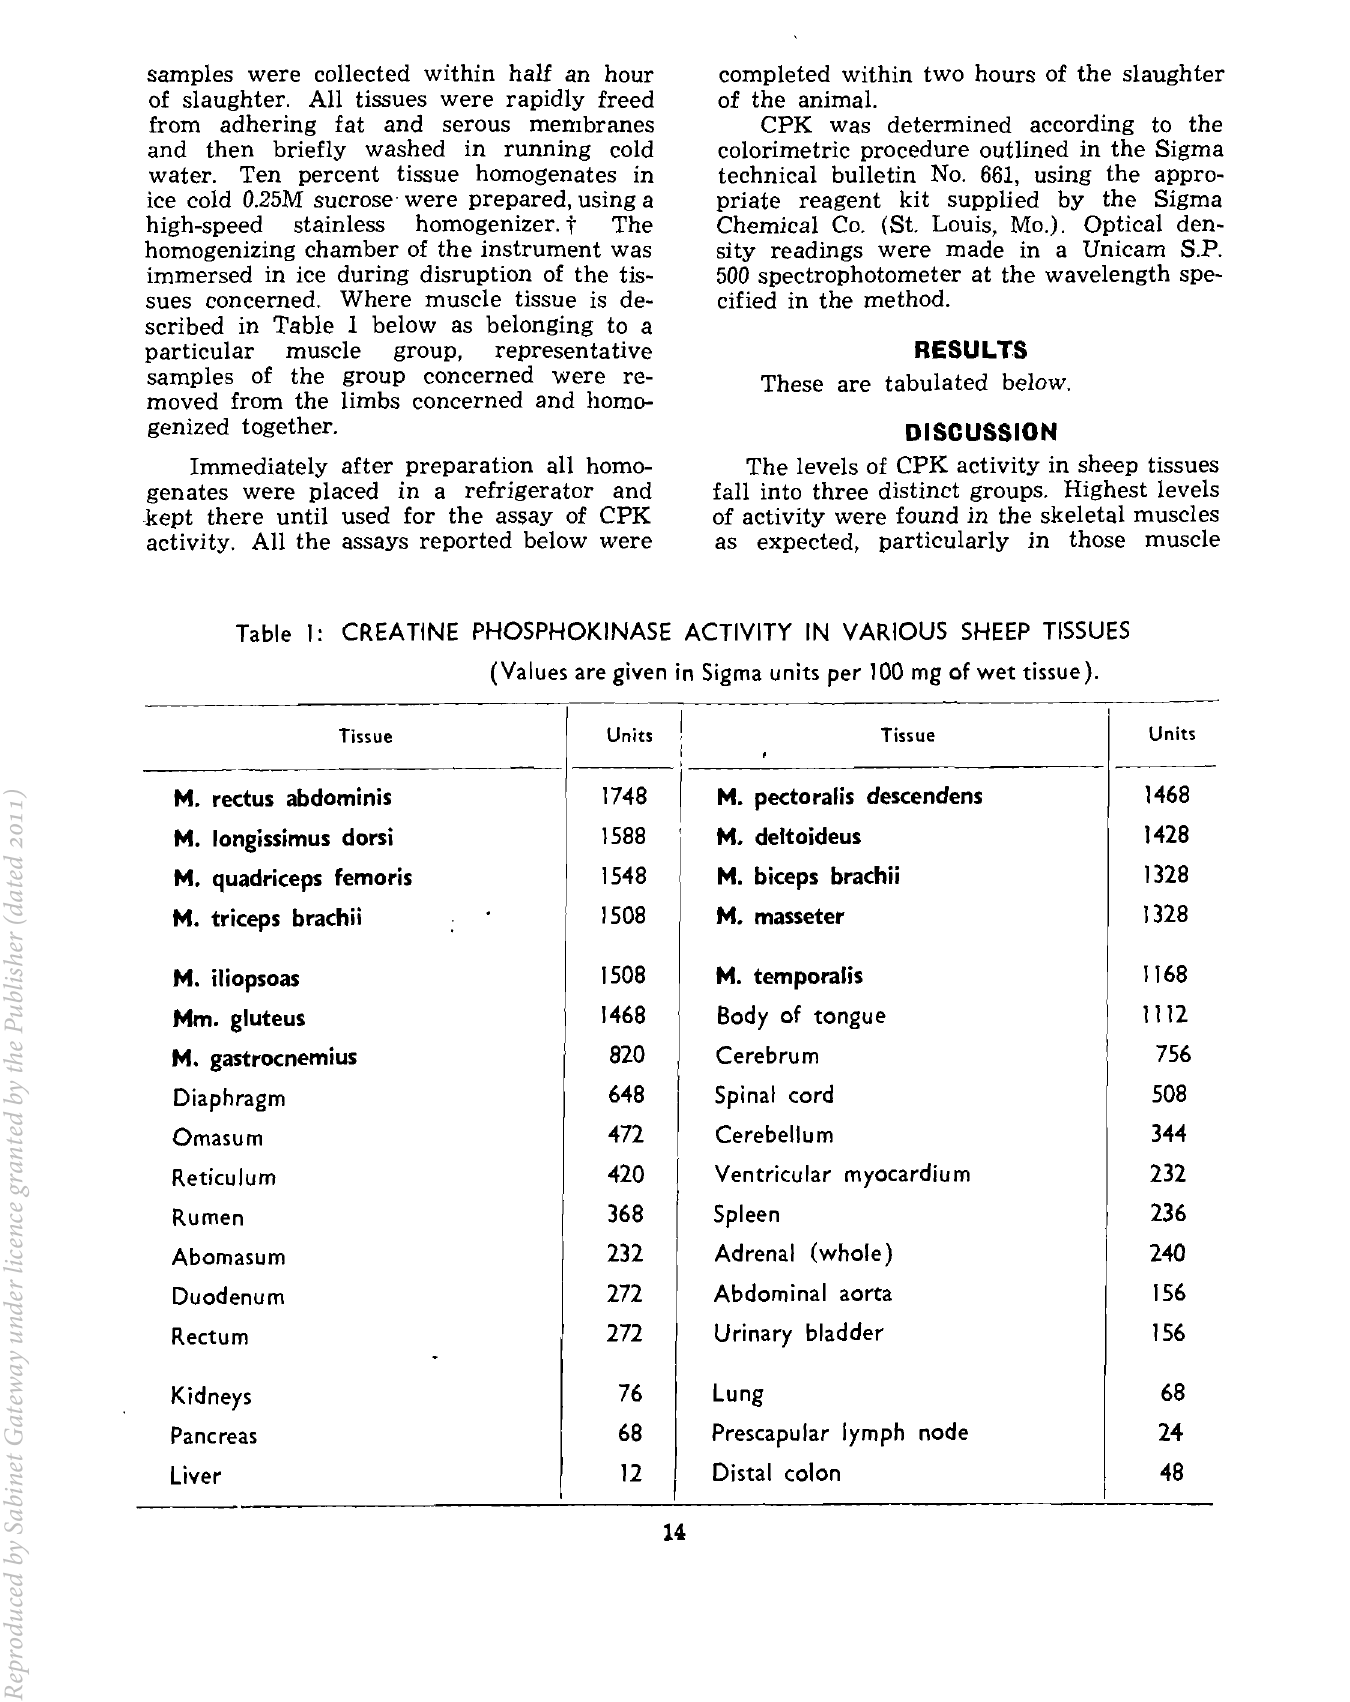
Table I: CREATINE PHOSPHOKINASE ACTIVITY IN VARIOUS SHEEP TISSUES (Values are given in Sigma units per 100 mg of wet